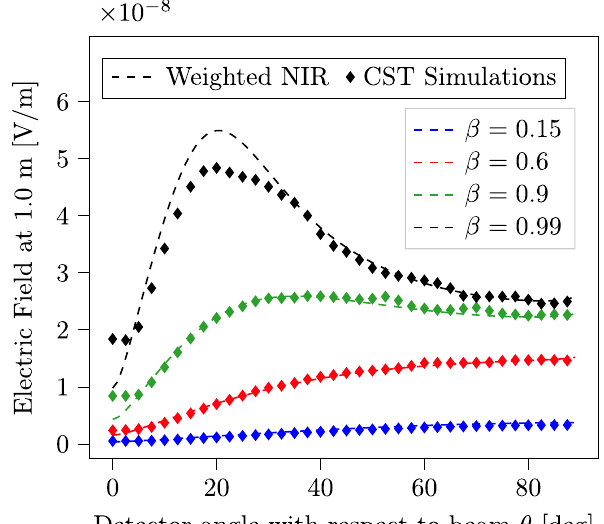
FIG. 11. Comparison of analytical and simulation angular field distribution at the peak field obtained for different velocities at R ¼ 1 . 0 m distance for a 100 ps bunch.